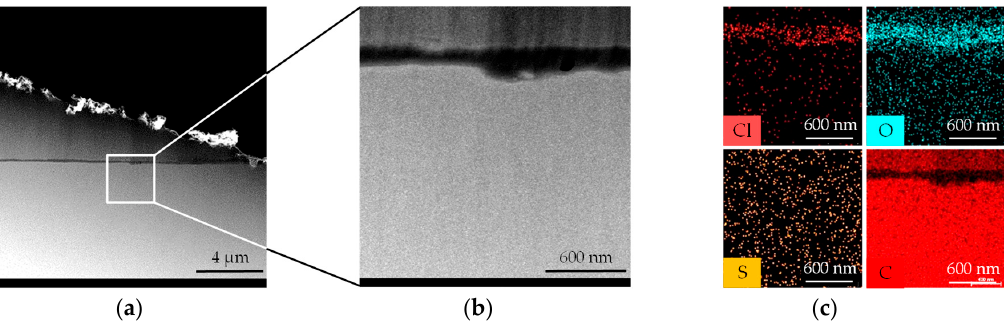
Figure 7. ( a ) Scanning TEM (STEM) measurement for analysis of density alterations in the subsurface region; ( b ) Magnification of STEM measurement spot; ( c ) Energy dispersive X-ray spectroscopy (EDX) analysis of material composition in the magnified area.